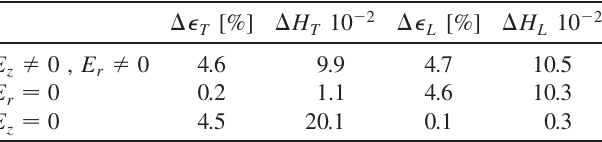
TABLE XIII. Effect of each field component ( v ¼ 340 kV ), uniform.